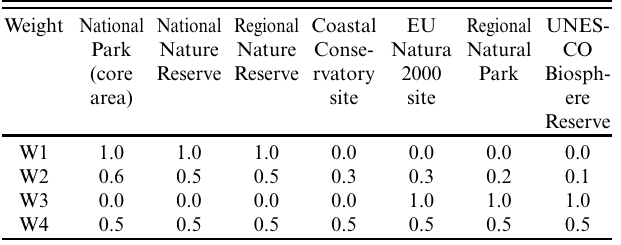
Table 2 . Weight attributed to each type of protected area in the two approaches of simulation of green fiscal transfers to municipalities in southern